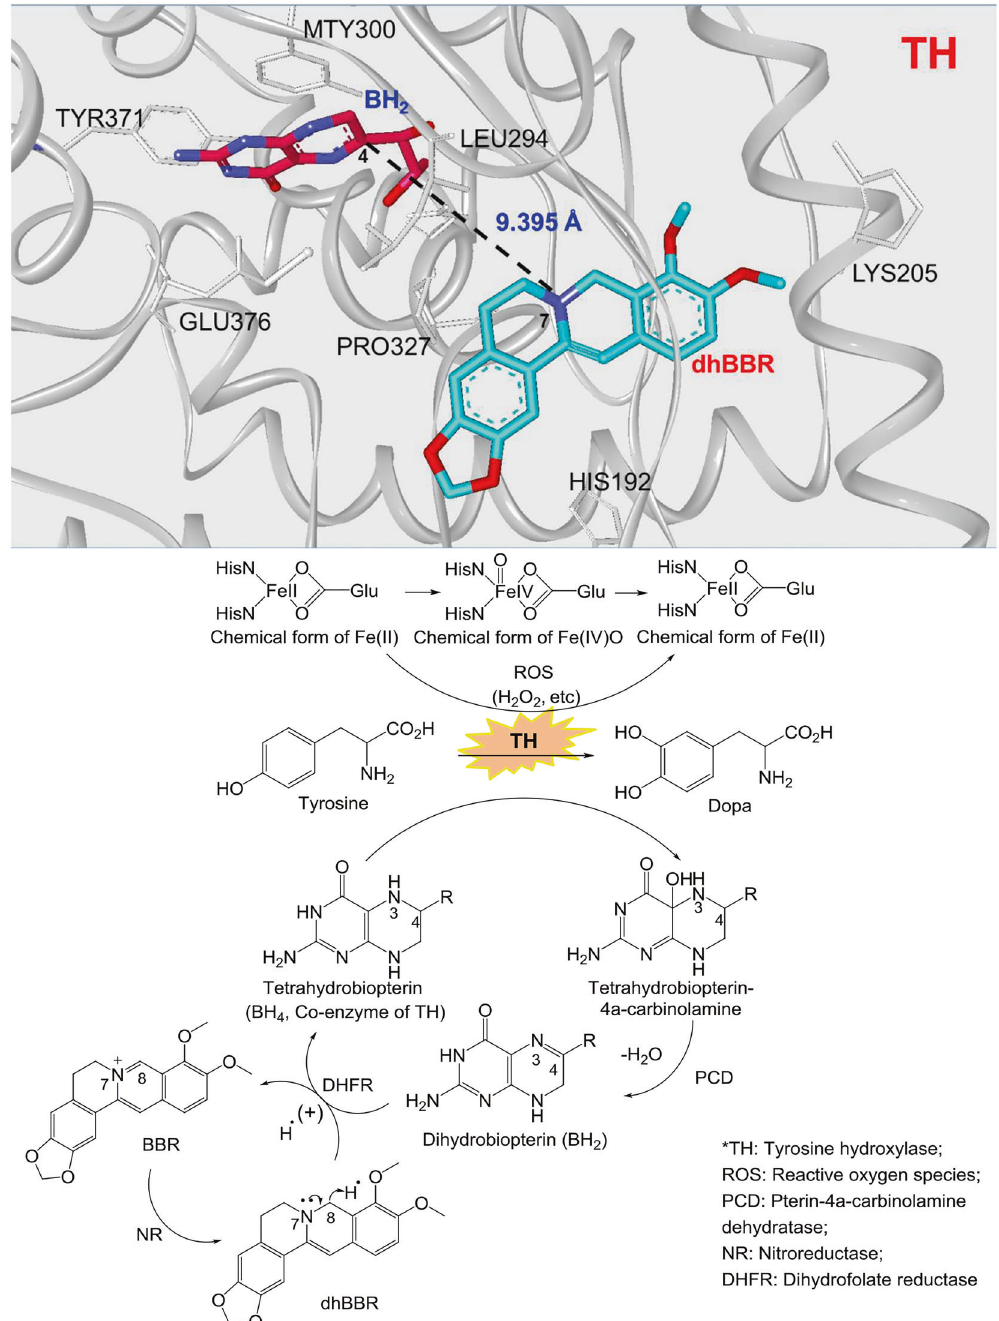
Fig. 4 The dhBBR-mediated chemical reaction for the conversion from tyrosine to dopa. BH 2 obtained H (cid:129) from the dhBBR – BBR system, and its reduction was activated, in which H (cid:129) from dhBBR (N 7 – C 8 ) moved to the N 3 = C 4 bond in BH 2 , and N 3 = C 4 was then transformed into N 3 – C 4 (BH 2 was converted into BH 4 ). In the meanwhile, dhBBR lost H (cid:129) , and was oxidized into BBR. The increased BH 4 in intestinal bacteria accelerates the transformation from tyrosine to L -dopa, in the presence of ROS (H 2 O 2 , etc.) as well as Fe 2 + . Accordingly, BH 4 is converted into tetrahydrobiopterin – 4 α -carbinolamine microbiota might not be the major contributor for brain dopamine (group 5 vs. group 3, Fig. 5d(L)). Levels of dopa/dopamine in in nature; thus, dopamine level in brain and blood is relatively plasma or feces showed an escalation pro fi le similar to that in stable, even the bacterial colony numbers decreased; and second, brain (Fig. 5e, f; group 5 vs. group 3, group 7 vs. group 3, ** P < 0.01 Enterococcus appeared relatively more resistant to the antibiotics and * P < 0.05, respectively). as compared with other bacteria in intestine (Supplementary Fig. As we have seen in Fig. 5d – f, treatment with antibiotics could S3j), thus the residual Enterococcus remains good production of reduce the bacterial colony in the mouse intestine; however, dopa dopa/dopamine. Other reasons might not be excluded. Actually, and dopamine in the feces, plasma, and brain of the PGF mice did dopamine level in brain was decreased by antibiotics ~10% not change signi fi cantly. The explanation could be fi rst that gut Signal Transduction and Targeted Therapy (2021)